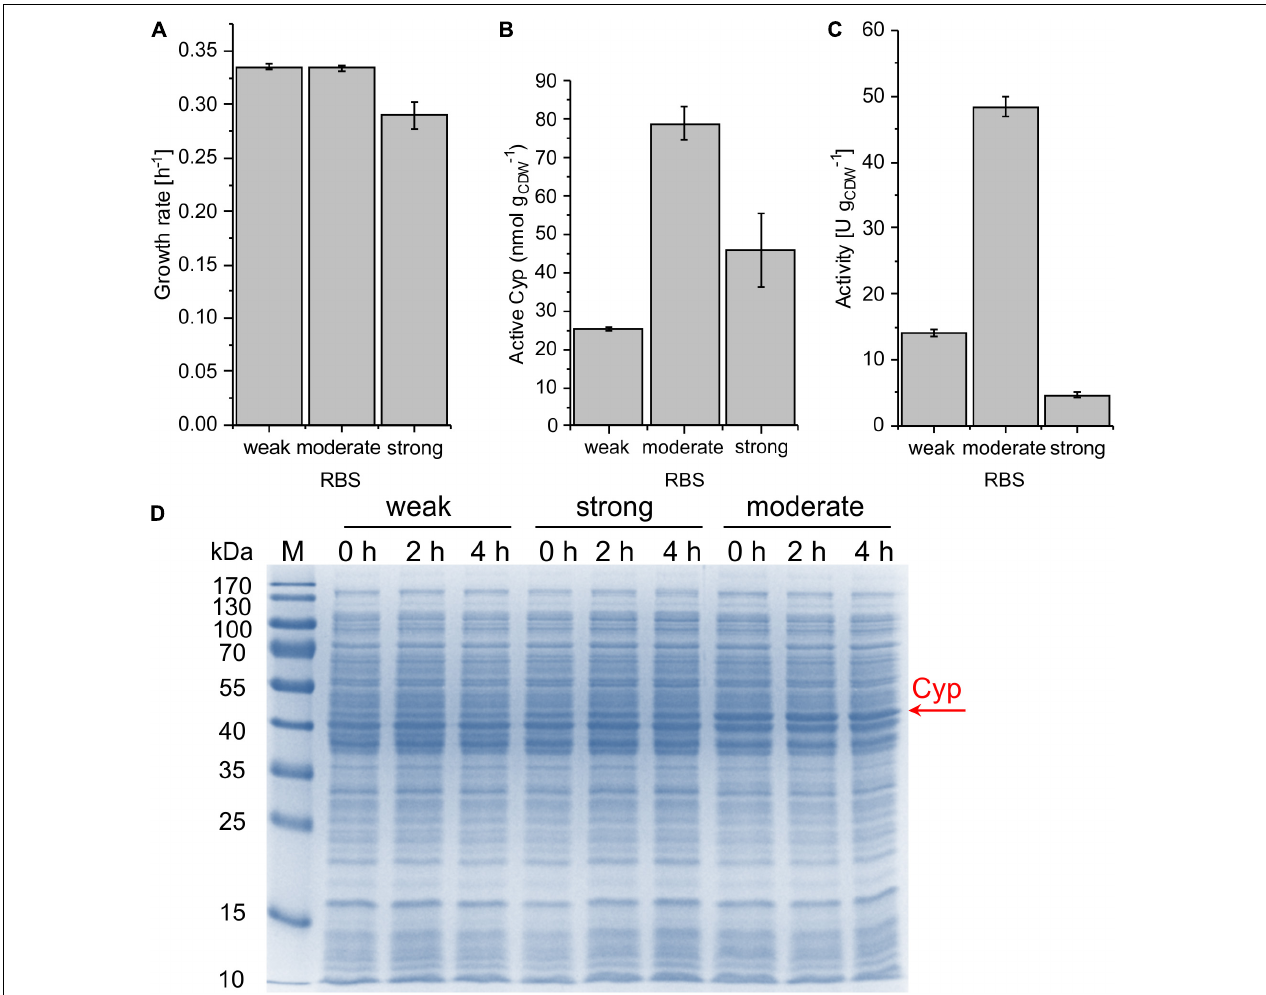
FIGURE 3 | Growth rate (A) , concentration of active Cyp determined via CO difference spectra (B) , and specific cyclohexane hydroxylation activity (C) of P. taiwanensis VLB120 pSEVA244_BB32_Cyp (weak RBS), pSEVA244_RBS ∗ _Cyp (moderate RBS), and pSEVA244_BB34_Cyp (strong RBS) after 4 h of induction. Resting cell assays were performed as described in Figure 2 with biomass concentrations of 0.2 and 0.5 g L − 1 . The bars represent average values. Standard deviations of two independent biological replicates are given. The average experimental errors over all measurements for the growth rate, active Cyp concentration, and activity are 2.0, 9.2, and 4.6%, respectively. SDS-PAGE analyses (D) of the strains used for activity assays show the corresponding Cyp content (at 47.4